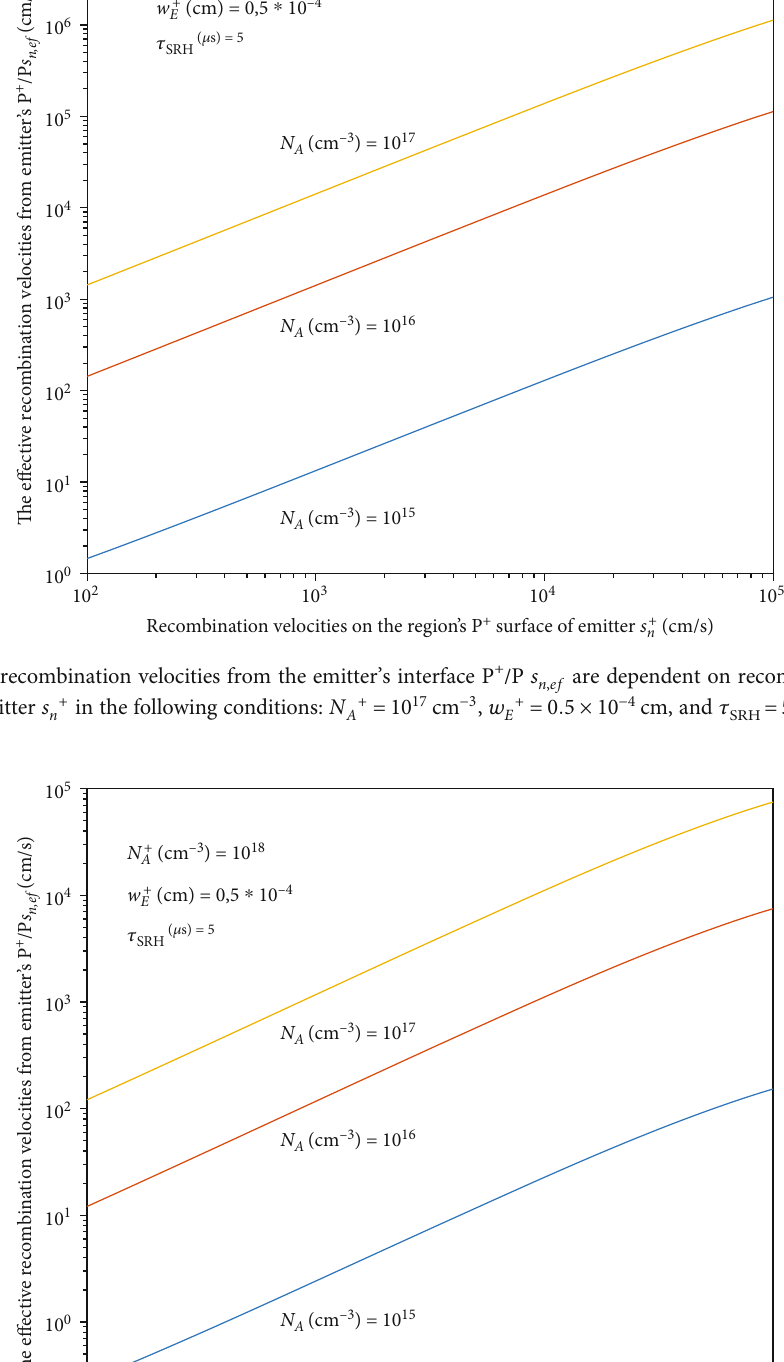
n , ef are dependent on recombination velocities on the = 5 μ s SRH